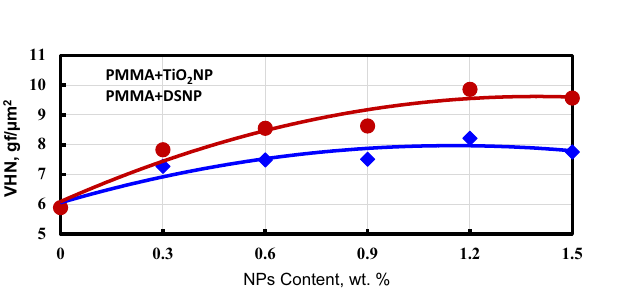
Figure 6. Improvement percentages of WR and µ at 1.2 wt% NP under an applied load of 30 N.